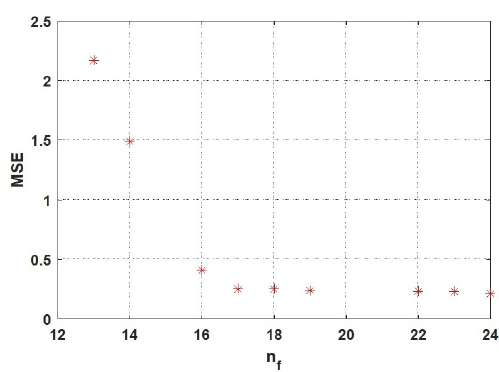
Figure 4. Pareto front derived from NSL-KDD.